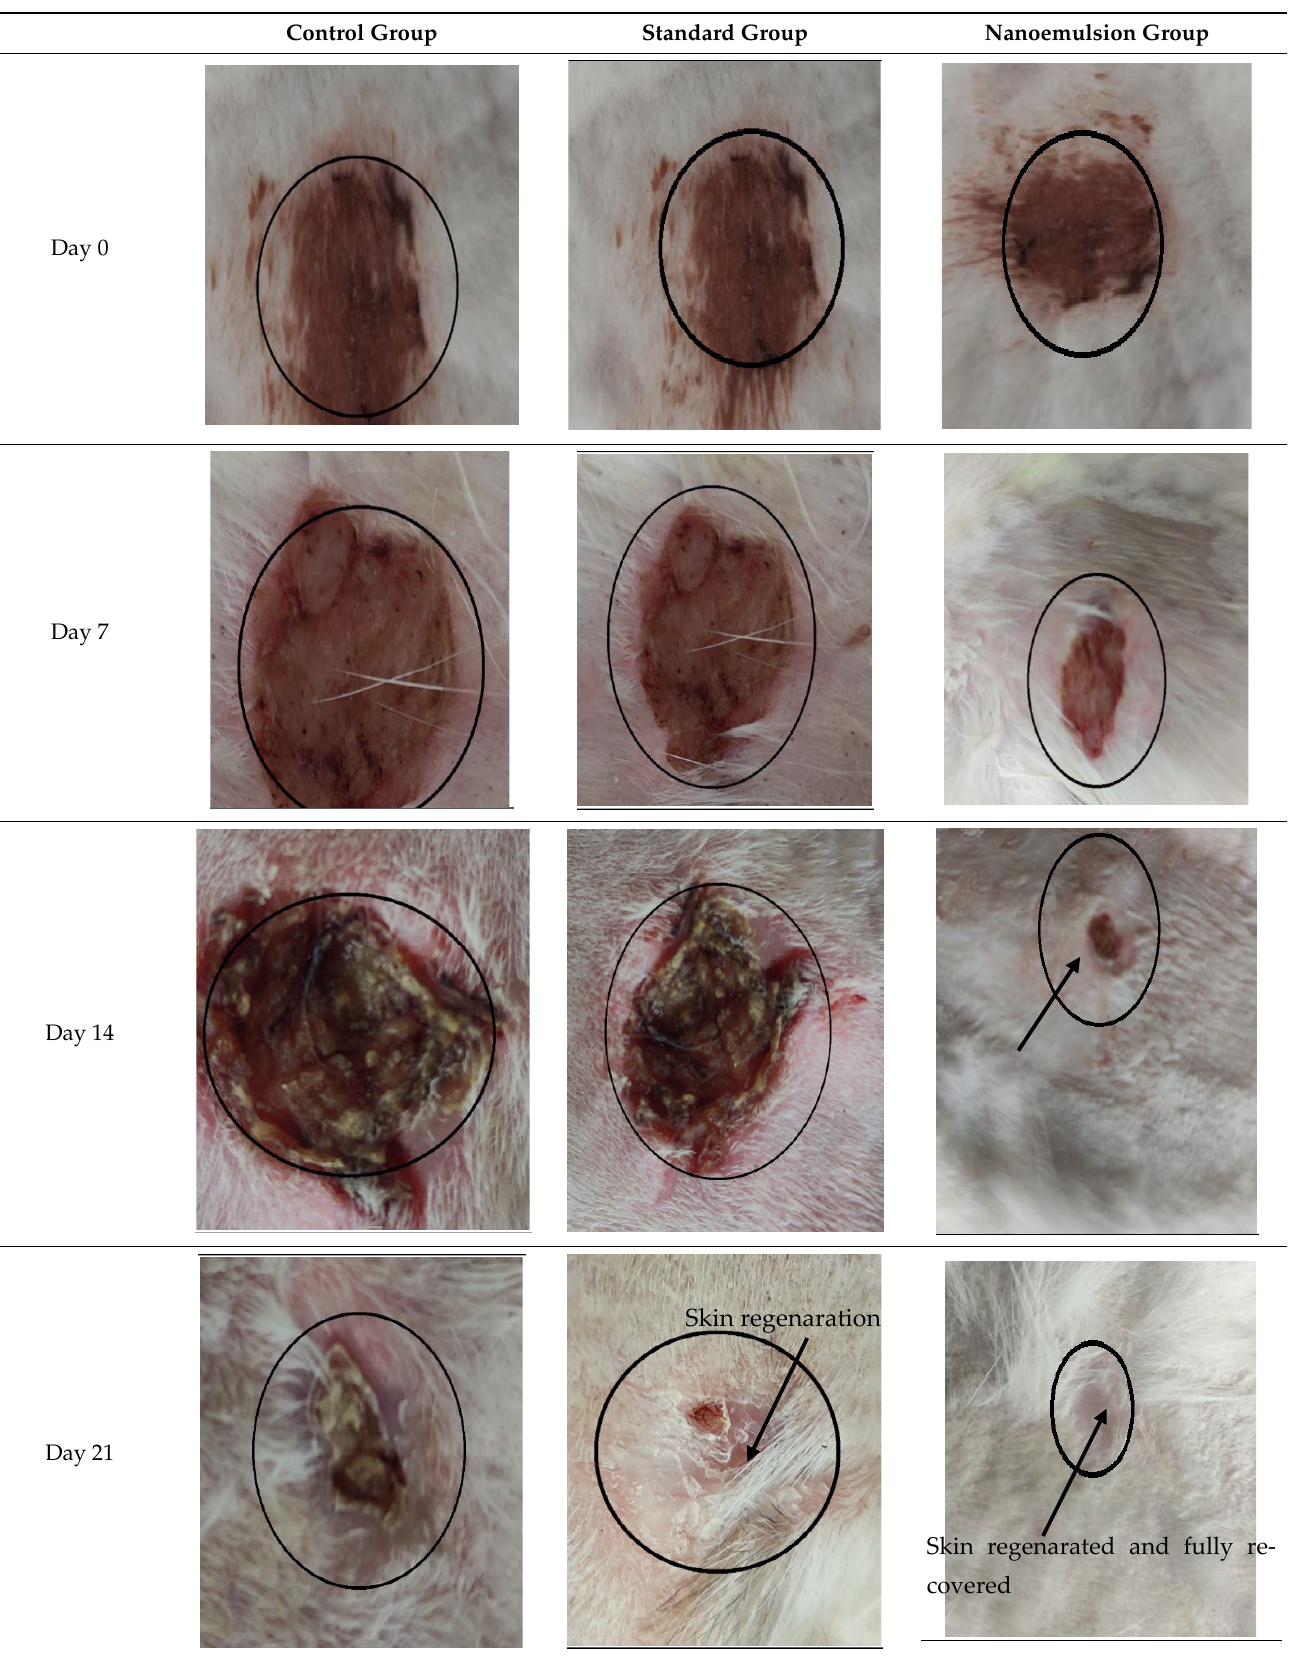
Figure 3. Shows time and wound healing progress in (cm), * indicate ( p < 0.05) and ** indicate ( p < 0.01) in statistical differences. Table 7. Healing of wound at different time intervals.